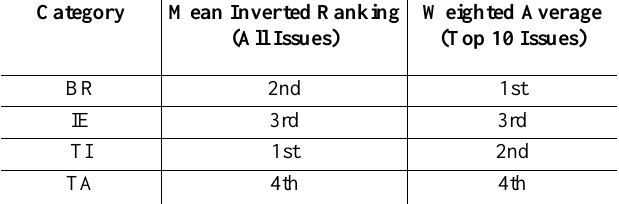
Table 3: Comparison of ranking